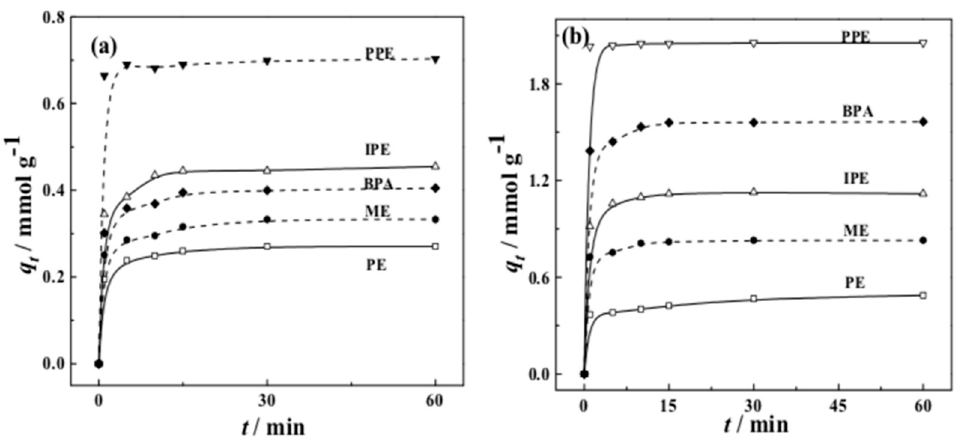
Figure 5. Adsorption capacity ( a ) graphene and ( b ) graphene oxide for phenols removal. Reproduced from ref [138]. Table 6. Adsorptions of PAHs and phenols onto graphene, GO and reduced graphene oxide (rGO) and their